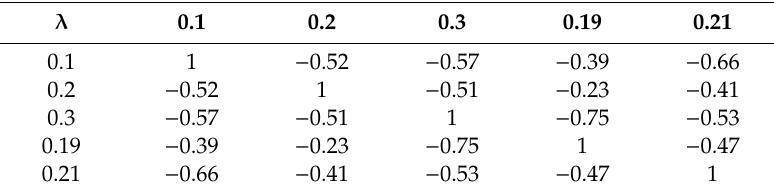
Table A11. The Pearson correlation coe ffi cients of the di ff erent values of λ when the edges were smoothed using IS. It confirms that our sample accuracy was